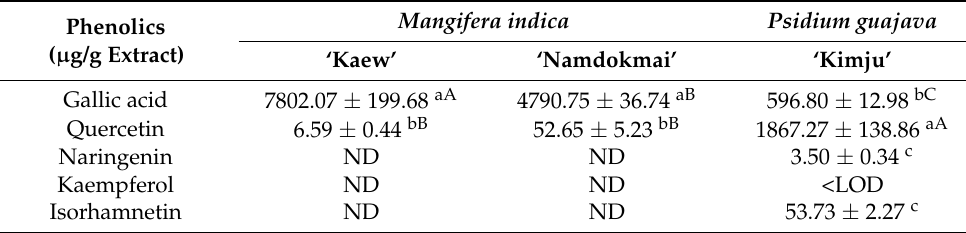
Table 2. Phenolic profiles of M. indica ‘Namdokmai’, M. indica ‘Kaew’, and P. guajava ‘Kimju’ extracts using liquid chromatography–electrospray ionization tandem mass spectrometry (LC–ESI-MS/MS). Phenolics ( µ g/g